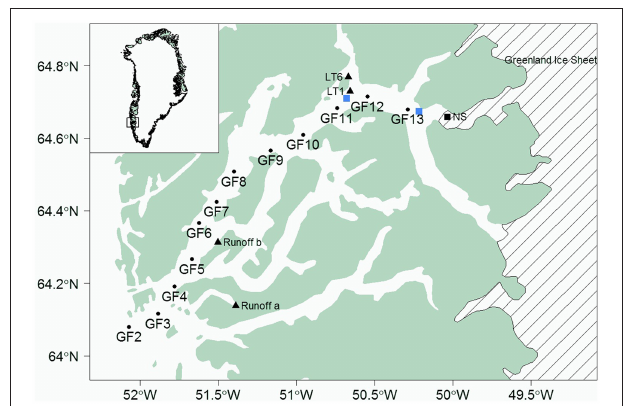
FIGURE 1 | Location of Godthåbsfjord showing fjord stations (GF x ), freshwater runoff collection points at Kobbefjord (a) and Sermitsiaq (b), Lake Tasersuaq estuary end stations (LT1 and LT6) and the marine terminating glacier Narsap Sermia (NS). GF11.5 and GF13.5 were conducted at the ice-edge (marked by blue squares close to GF11 and GF13 respectively).